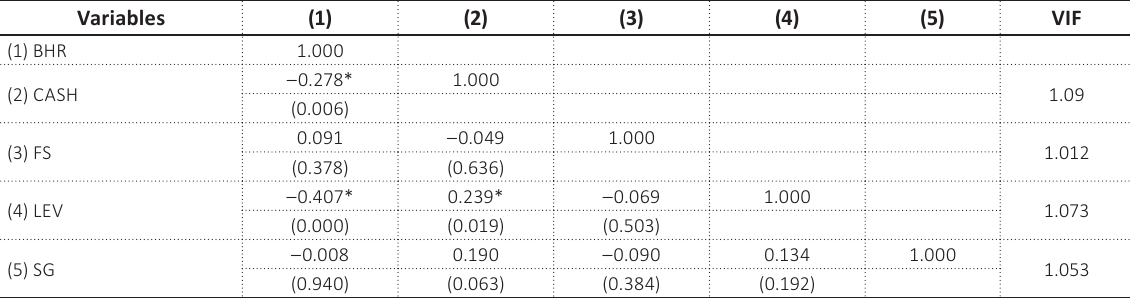
Table 3. Correlation